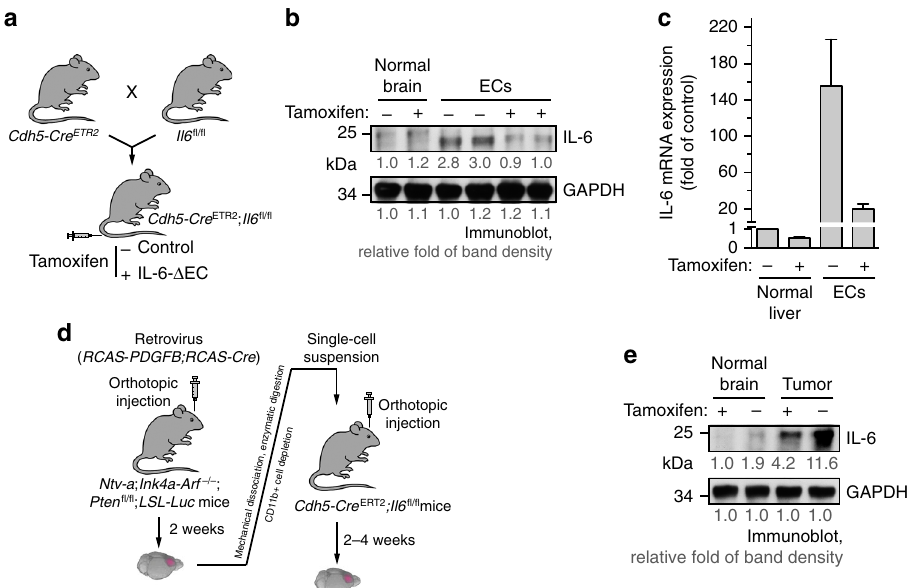
Fig. 7 ECs are a major source for IL-6 expression in GBM. a – c Cdh5 - Cre ERT2 ; Il6 fl / fl mice were generated by crossing Cdh5 - Cre ERT2 mice with Il6 fl / fl mice. Mice (2 weeks old) were injected with tamoxifen for consecutive 5 days to induce EC-speci fi c IL-6 knockout. a Schematic approach. b , c ECs were isolated from mouse aortas. b Brain tissue and ECs were subjected to immunoblot analysis. Band density was quanti fi ed. c mRNA was extracted and subjected to quantitative RT-PCR analysis. Results were normalized with GAPDH level and expressed as folds of control ( n = 3, mean ± SEM). d , e The primary GBM in Ntv-a ; Ink4a-Arf − / − ; Pten − / − ; LSL-Luc donor mice was induced by RCAS-mediated somatic gene transfer. Recipient mice were Cdh5 - Cre ERT2 ; Il6 fl / fl mice. d Schematic approach. e Normal brain and tumor tissues were homogenized. Tissue lysates were immunoblotted. Band density was quanti fi